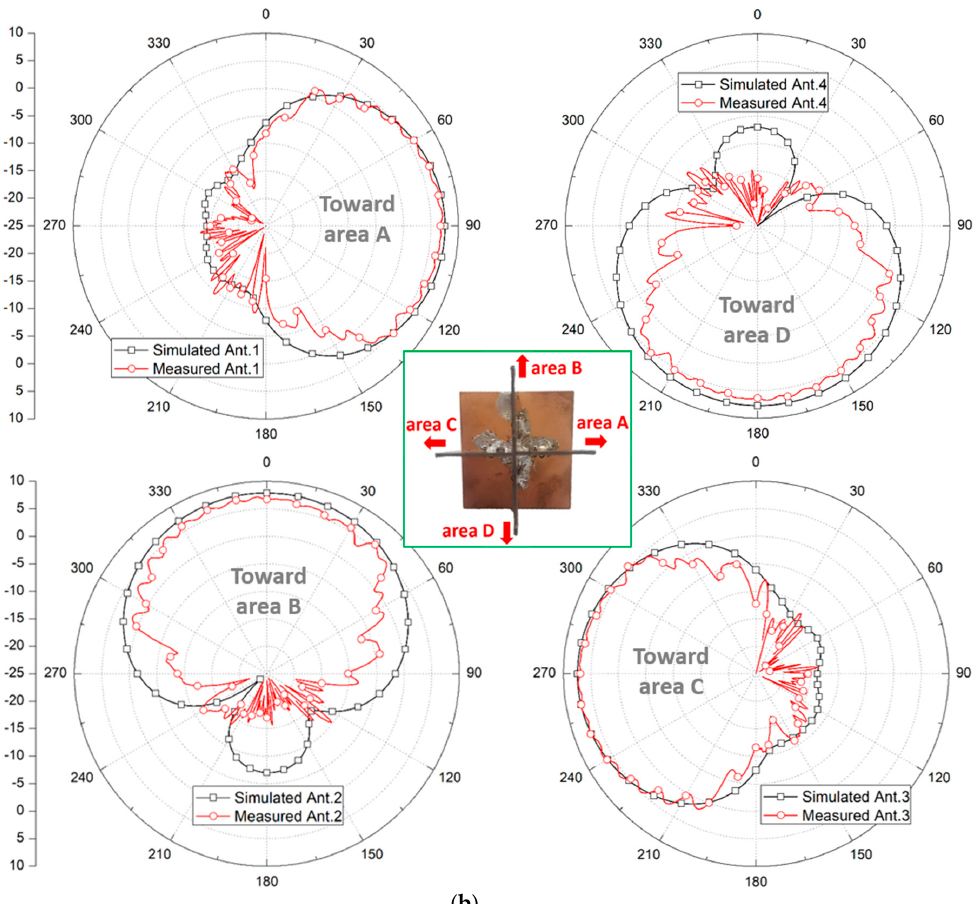
Figure 11. Simulated and measured radiation patterns of the proposed antenna array in the ( a ) elevation plane and ( b ) azimuth plane.